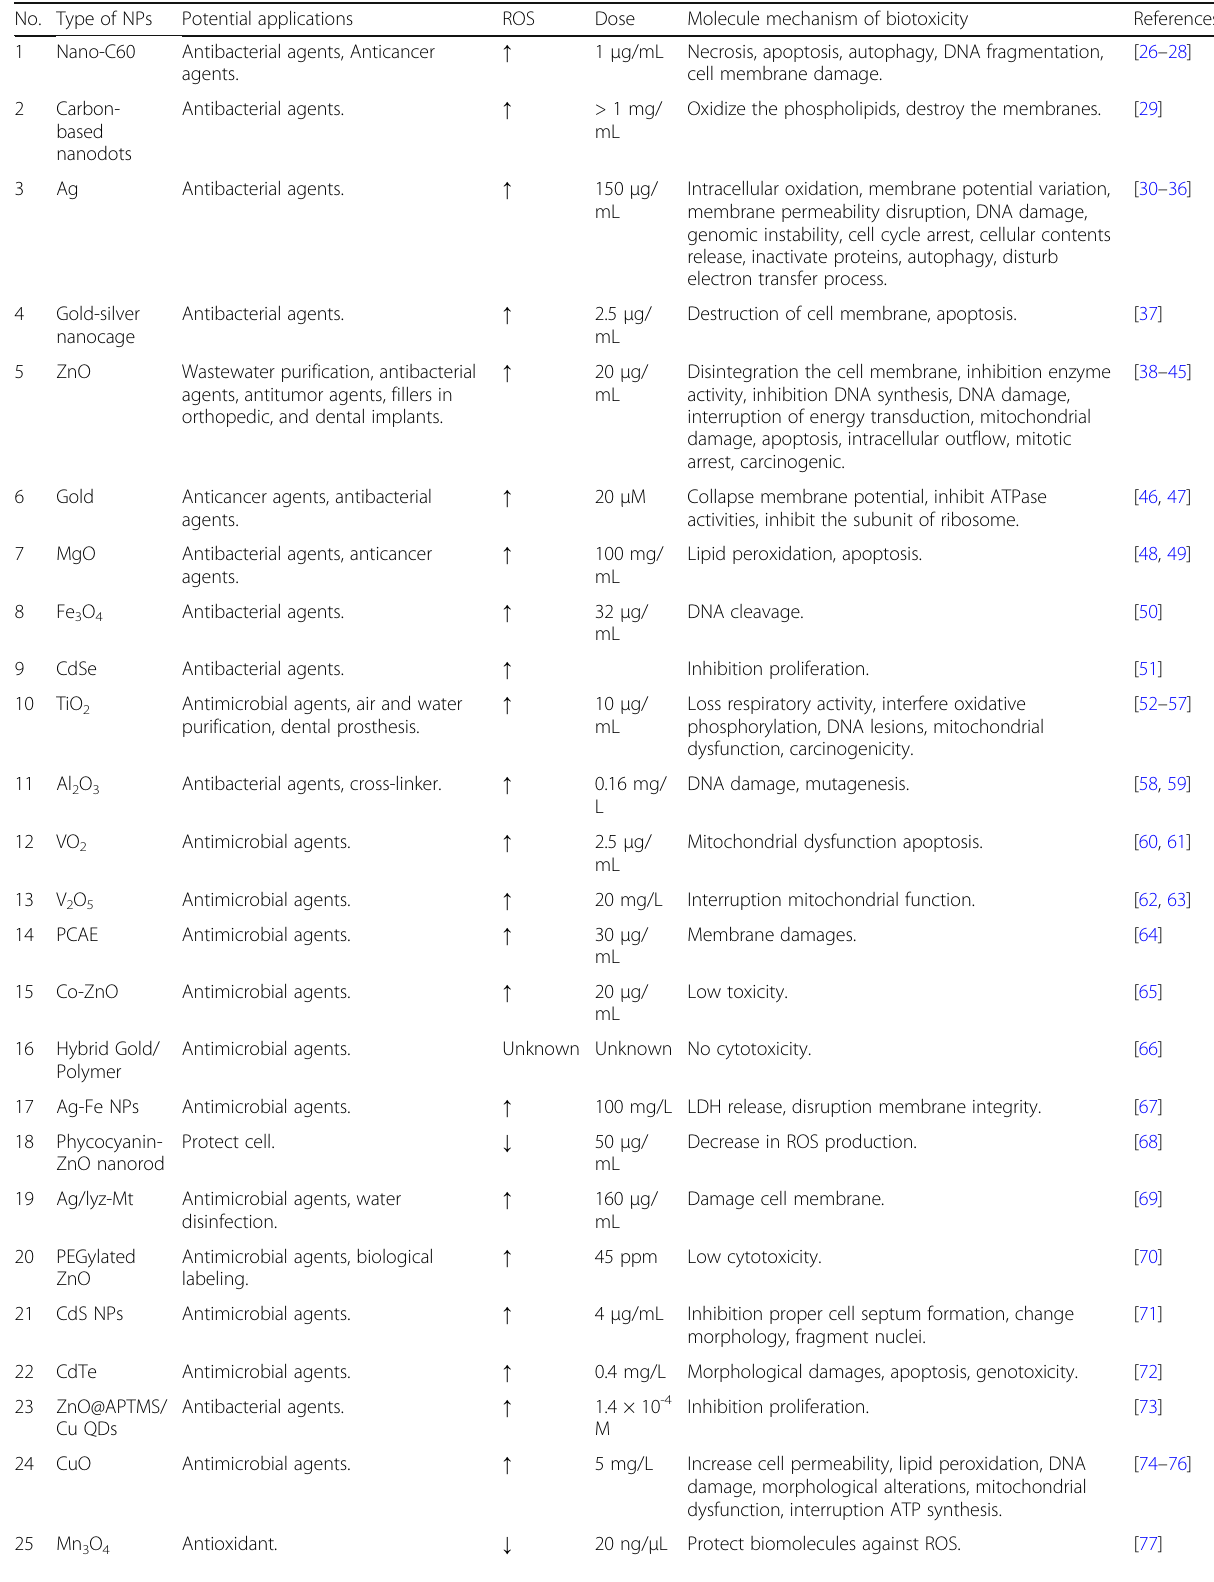
Table 1 NPs played their biologic role by inducing ROS burst in cells No. Type of